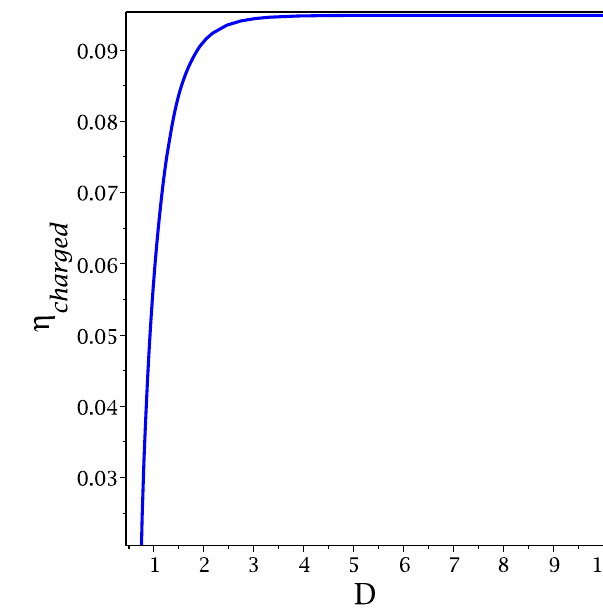
Fig. 16 η uncharged vs radius D . We have chosen m 0 = − 80, H 0 = 70, A = 1, (cid:8)(ε) = − 1, and H (ε) = 1 . 1